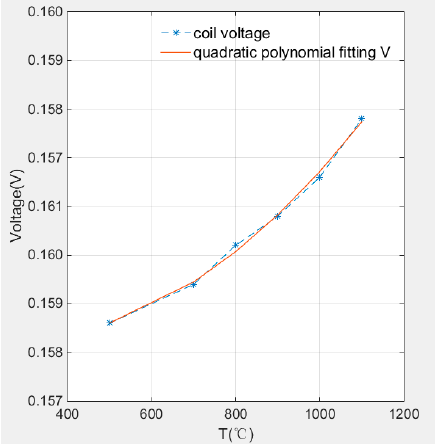
Figure 15. Coil voltage curve with temperature.